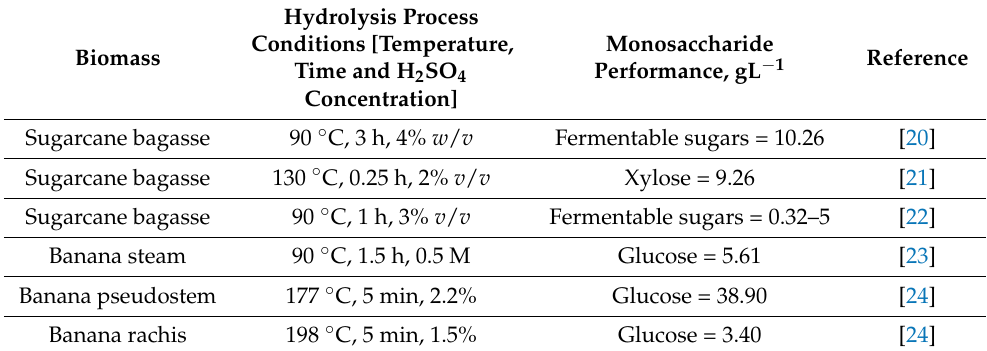
Table 1. Results of acid hydrolysis with sulfuric acid of sugarcane bagasse or biomass of the banana plant. Hydrolysis Process Conditions [Temperature, Monosaccharide Biomass Reference Time and H 2 SO 4 Performance, gL − 1 Concentration] Sugarcane bagasse 90 ◦ C, 3 h, 4% w / v Fermentable sugars = 10.26 Sugarcane